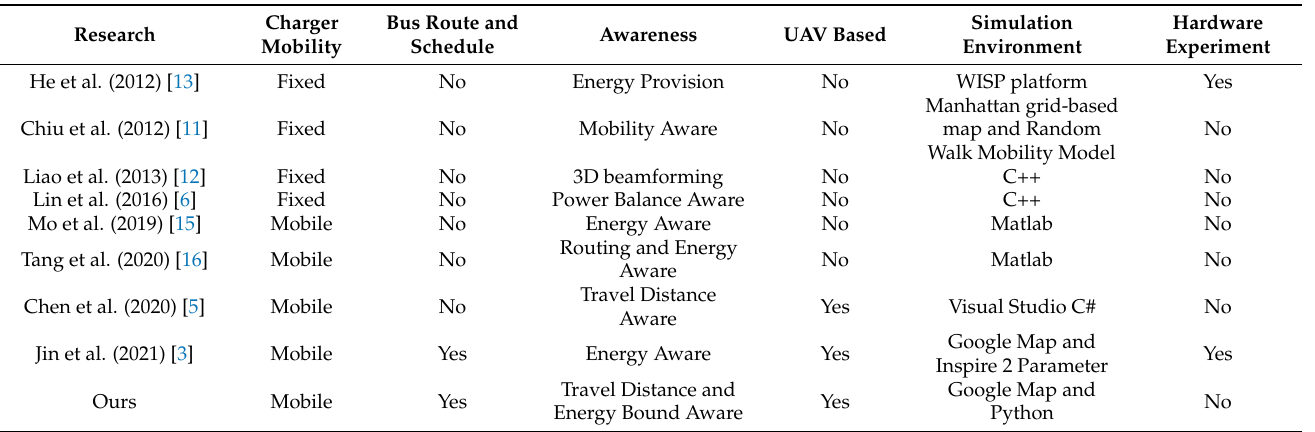
Table 1. Related deployment